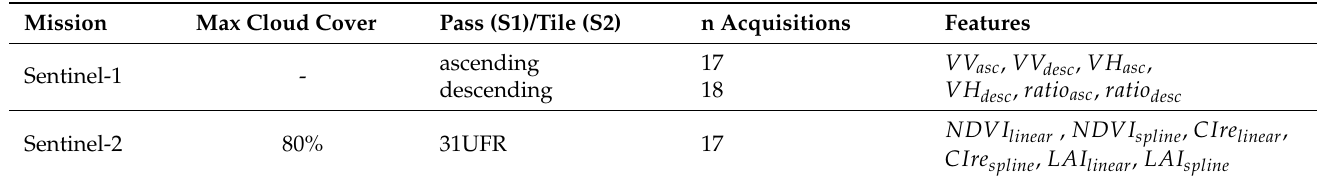
Table 1. Sentinel-1 and 2 images acquired during the study period (April 9 to July 19, 2019) and used to compute the classification